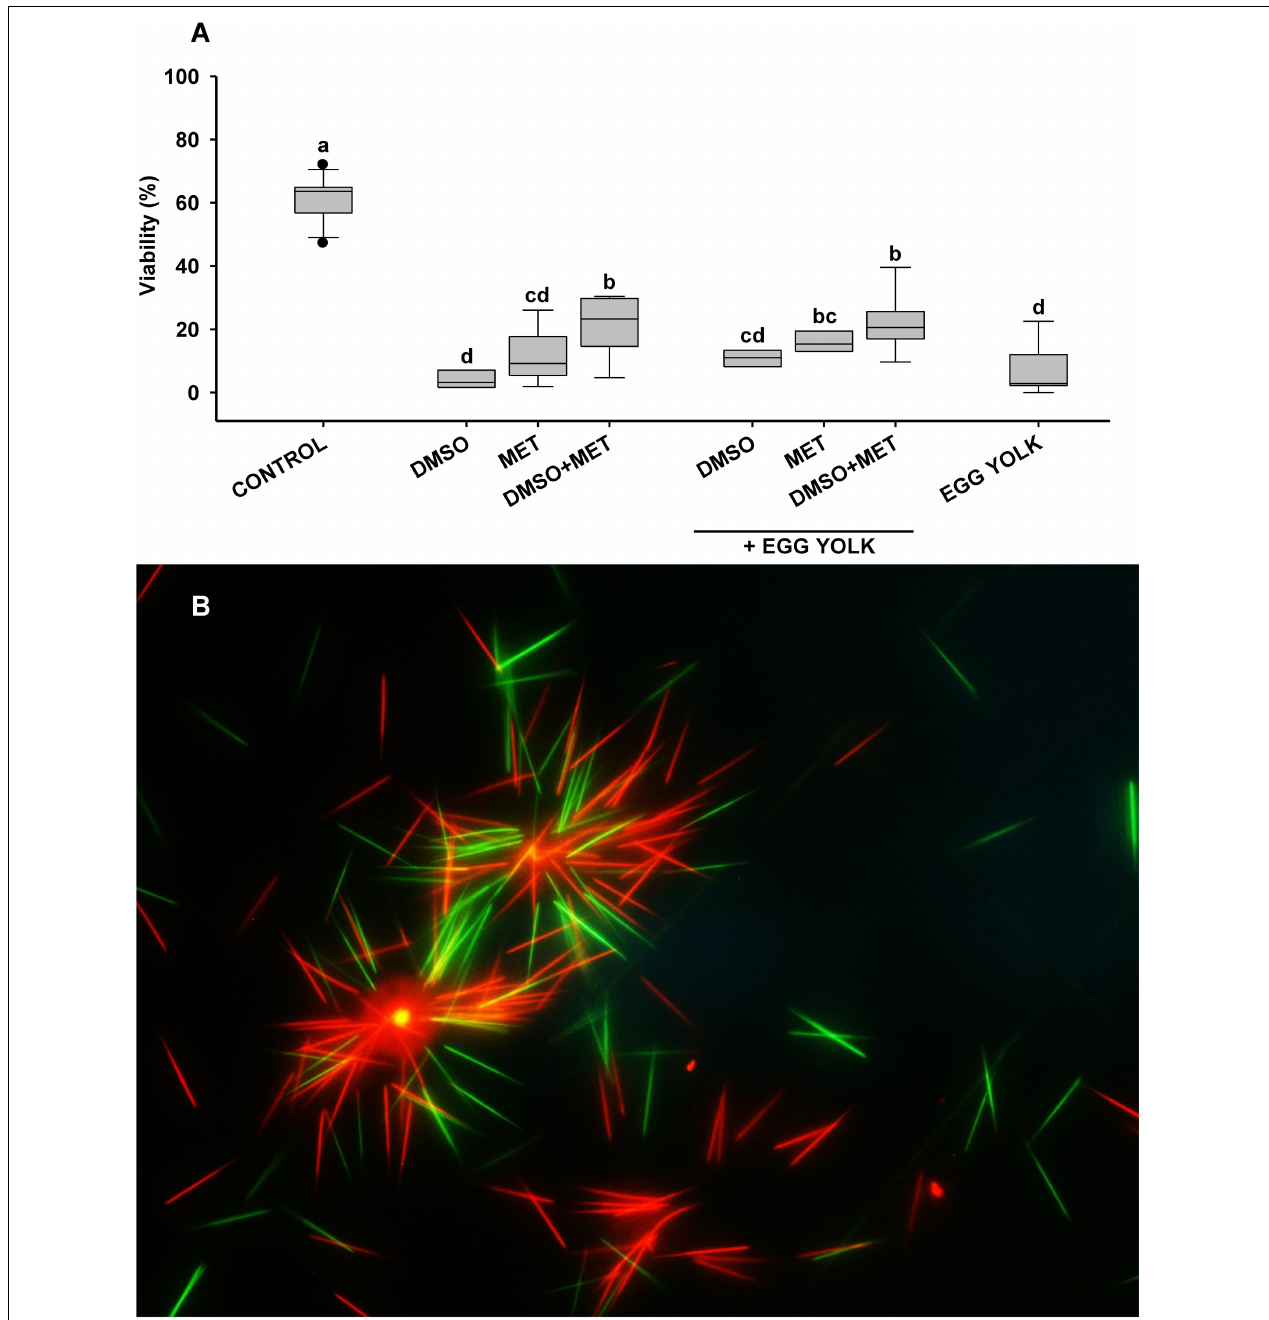
FIGURE 7 | Viability after cryopreservation in sharks. (A) Viability results for cryopreservation protocols in small spotted catshark ( n = 11). Sperm obtained from Scyliorhinus canicula was diluted with artificial elasmobranch seminal plasma extender (EE) and frozen using different cryoprotectant combinations: dimethyl sulfoxide (DMSO), methanol (MET) and fresh egg yolk. FRESH represents the motility and viability values in fresh sperm samples prior to freezing. Different letters mean significant differences between viability or motility values from each protocol. (B) Stained sperm to study the viability of the thawed spermatozoa by assessing their plasma membrane integrity. SYBR-14 stains intact cells green, and propidium iodide (PI) stains damaged cells red. Stained samples were observed under a fluorescence microscope (Nikon Eclipse 80i) at 10 ×